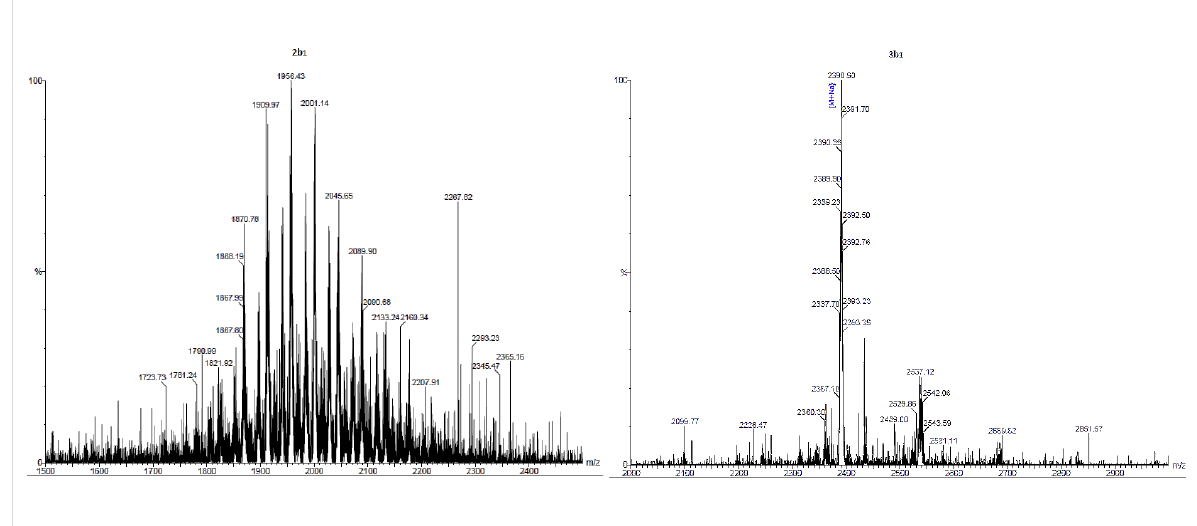
Figure 1: ESI MS spectra of CD derivatives 2b 1 (left) and 3b 1 (right).